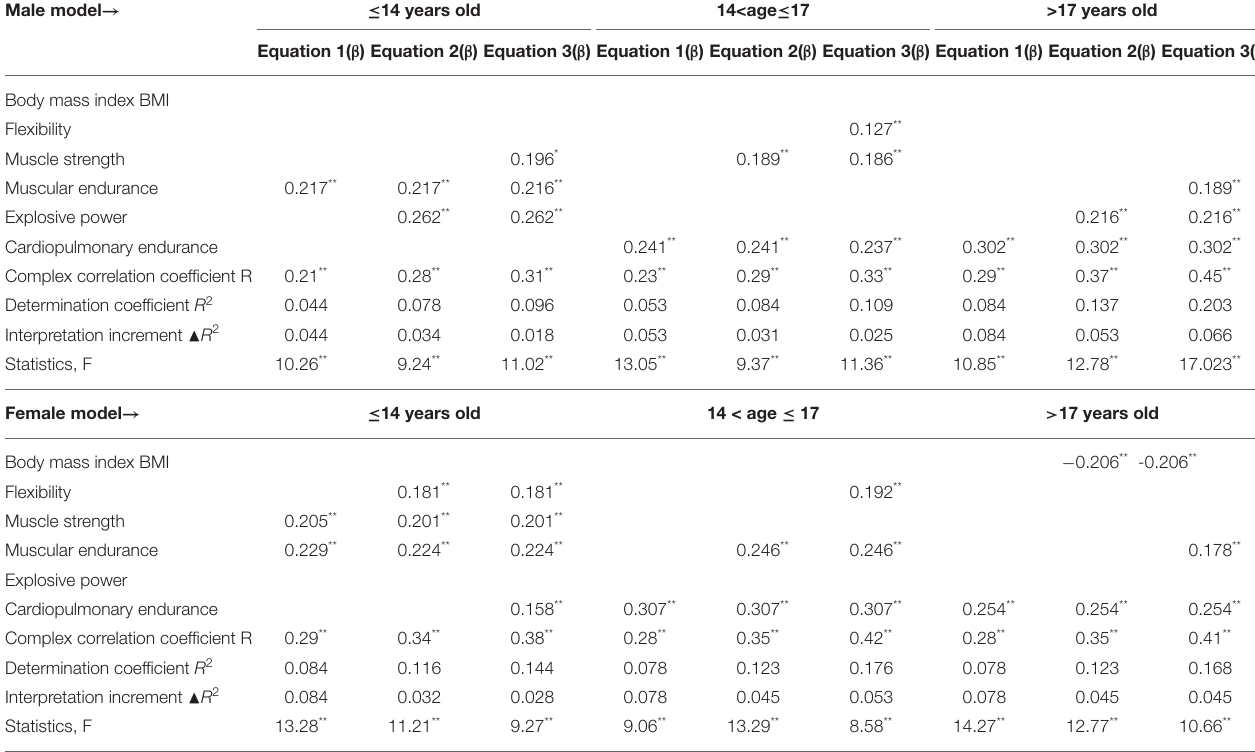
TABLE 4 | Multiple stepwise regression analysis statistics of health and physical fitness of adolescents of different ages on their overall health-promoting lifestyle. Male model